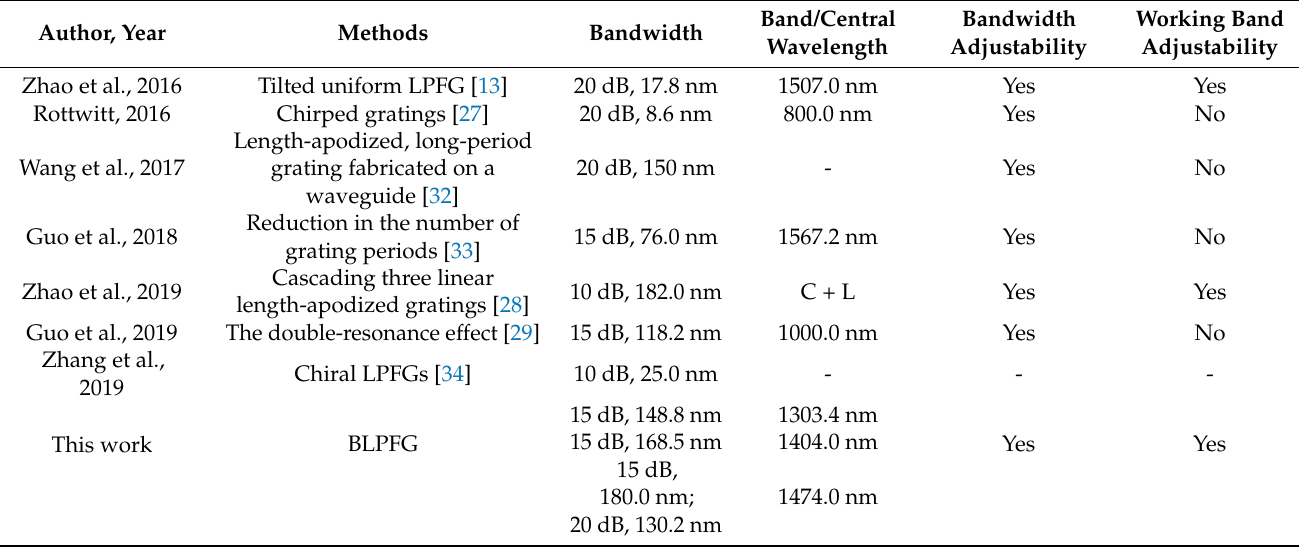
Table 3. Data comparison of different methods to increase the mode conversion bandwidth in recent years.